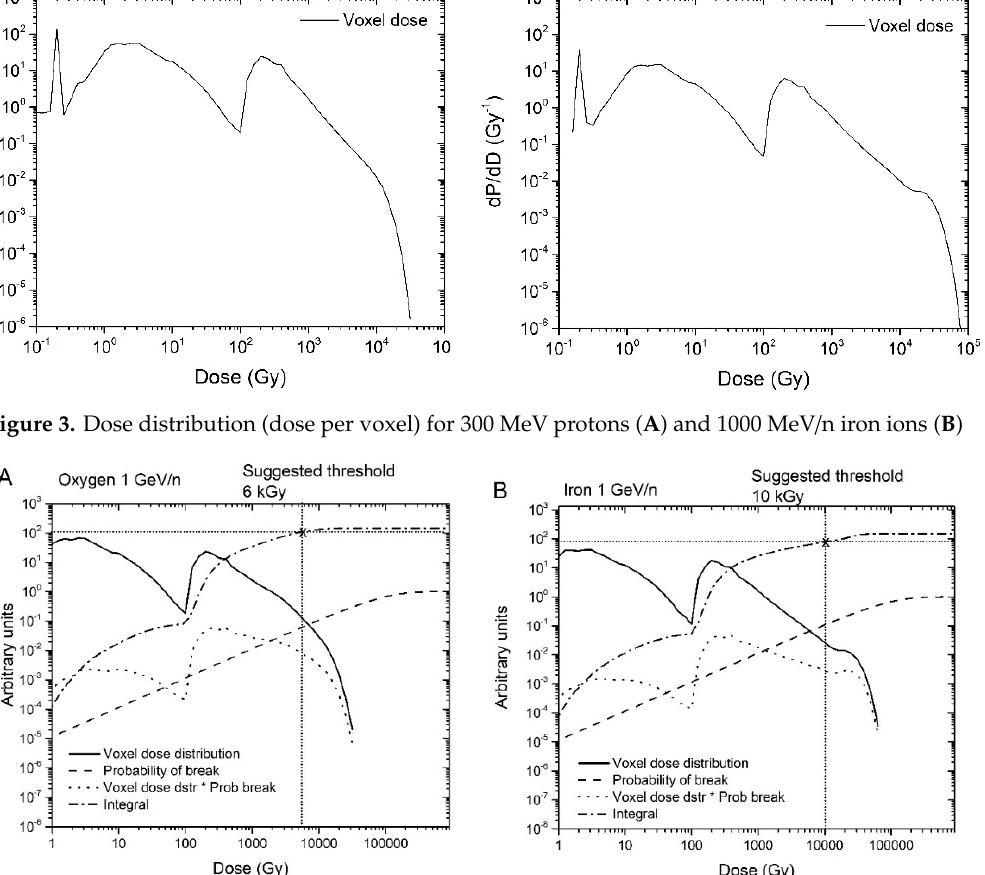
Figure 3. Dose distribution (dose per voxel) for 300 MeV protons ( A ) and 1000 MeV/n iron ions ( B )